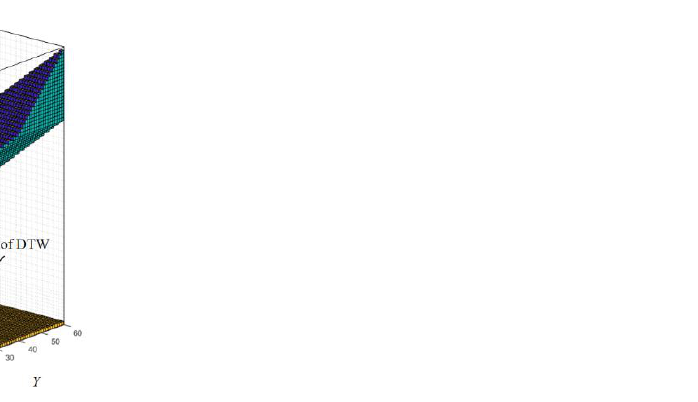
Figure 2. Comparison of the space and calculated amount between LDTW and DTW (tested on UCR data named SyntheticControl). The biggest cube is the CDM of LDTW, while the bottom part is the CDM of